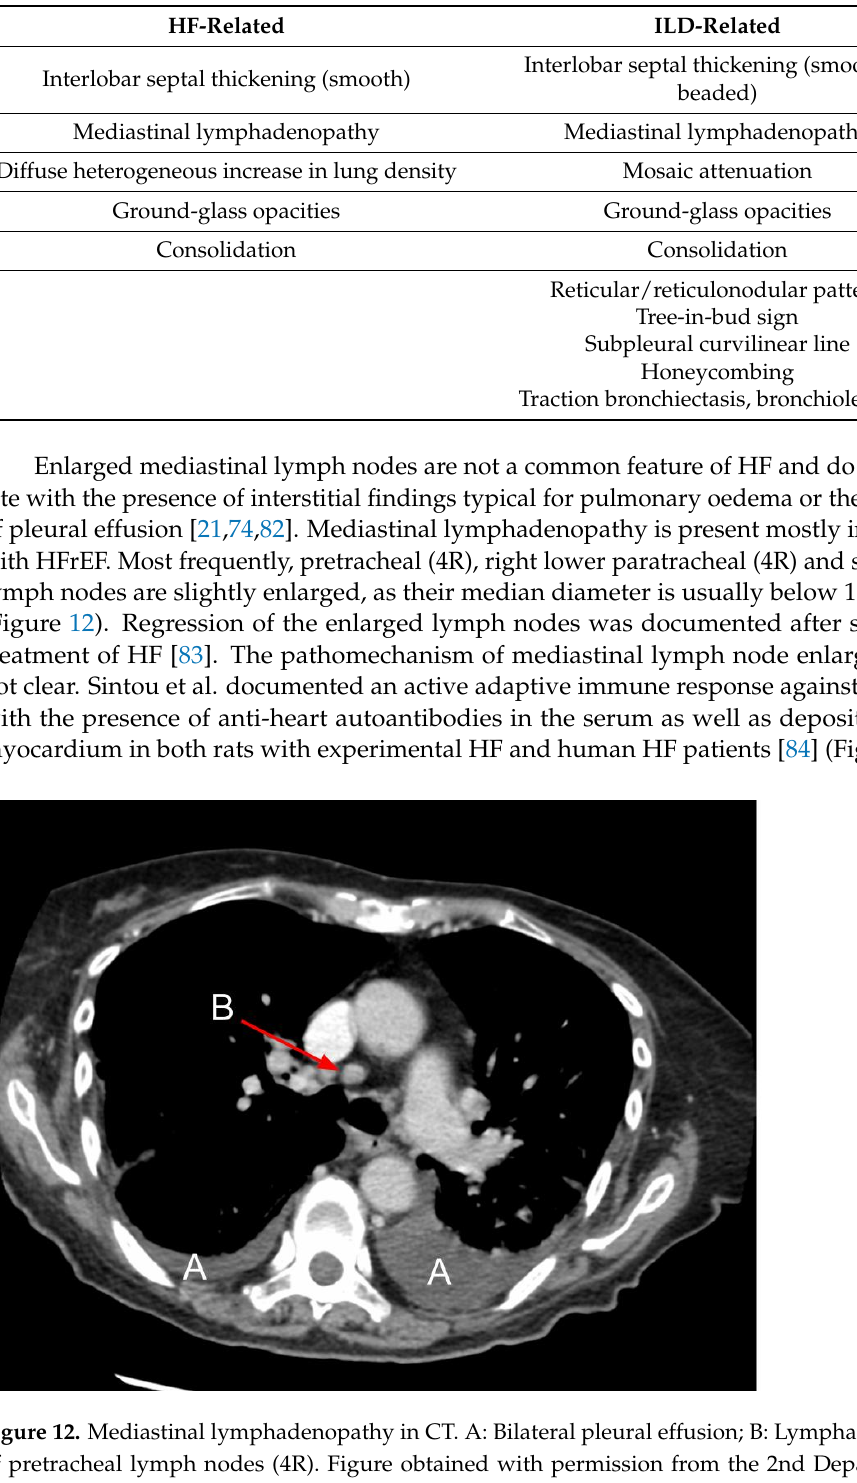
Table 1. Comparison of HF- and ILD-related changes in CT lung image.